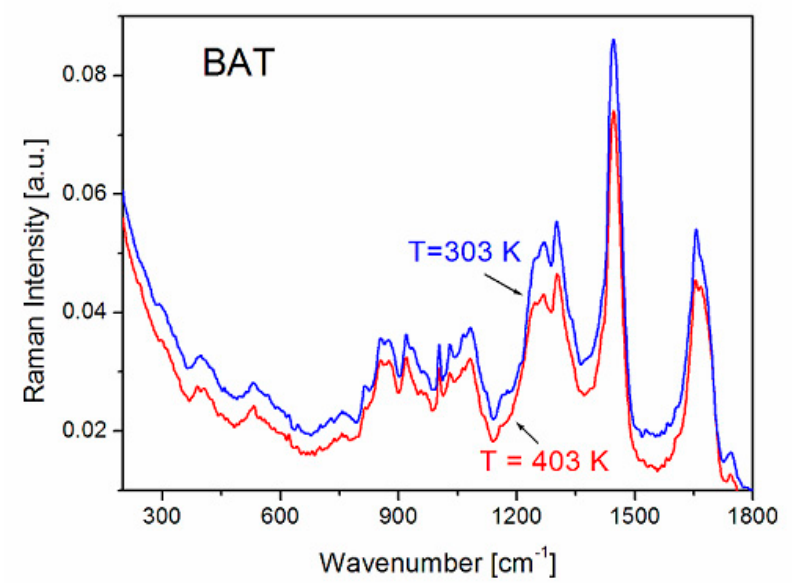
Figure 7. Comparison of the Raman spectra of BAT collagen measured at 303 K and 403 K.